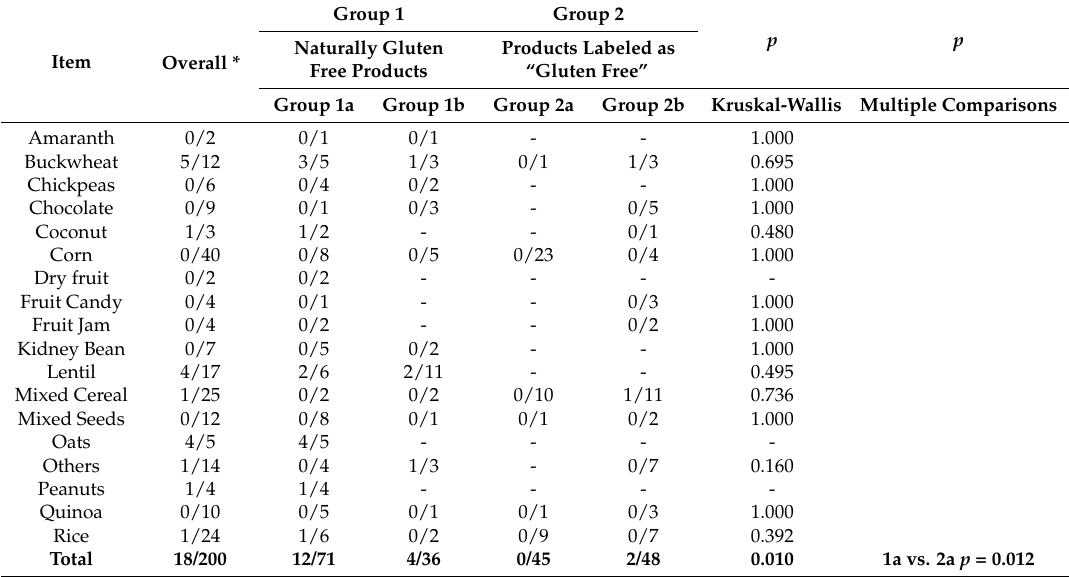
Table 2. Proportion of items containing >20 ppm of gluten by staple ingredient (contaminated/tested products).